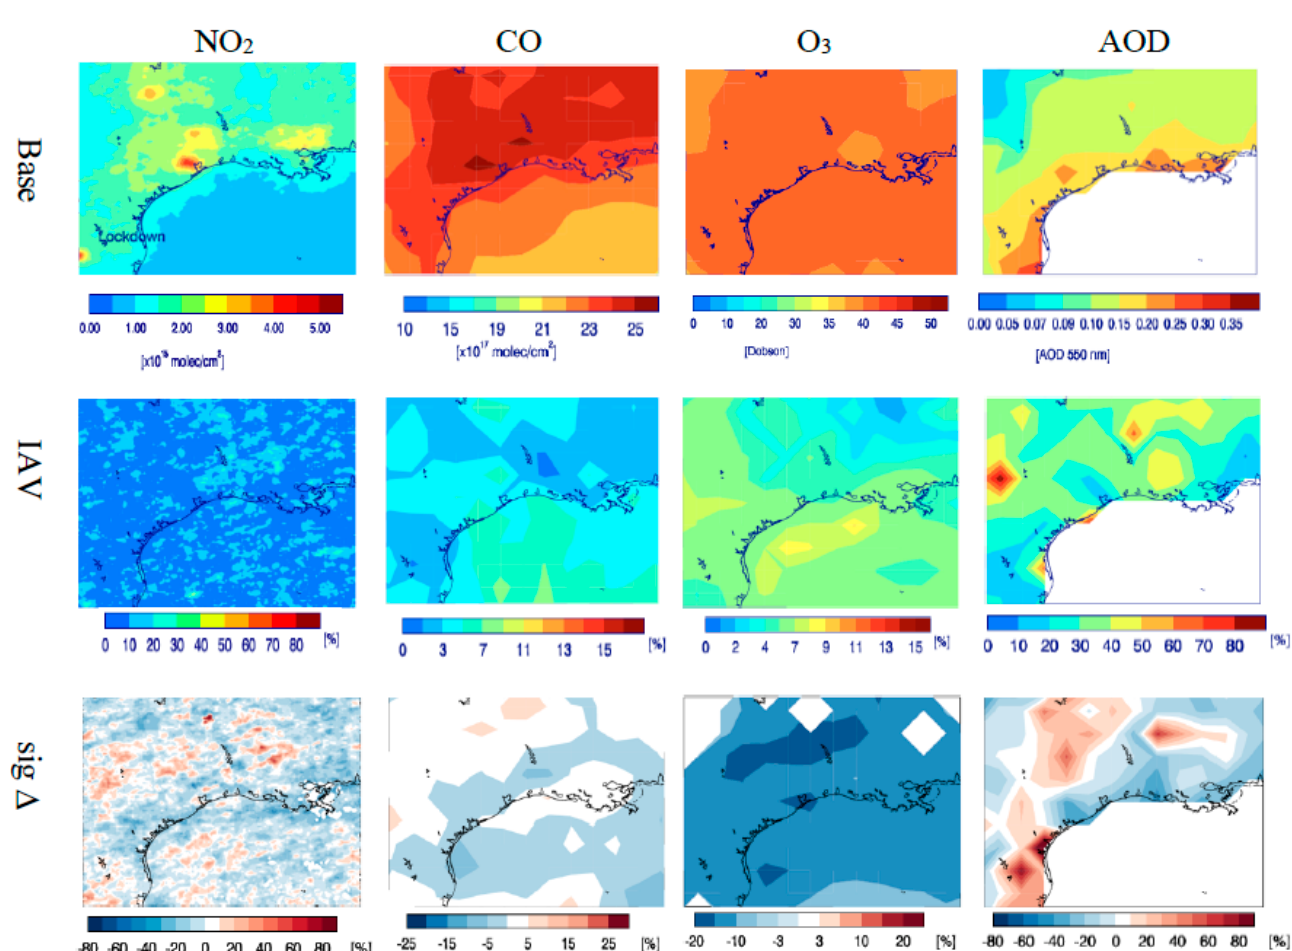
Figure 9. Same as Figure 3, but for the southern US.